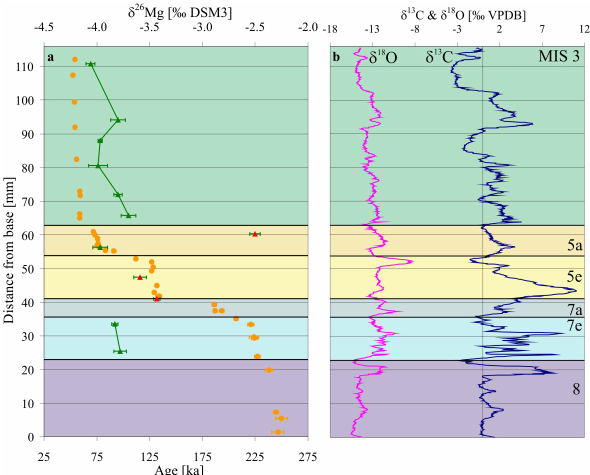
Fig. 10. Magnesium, carbon and oxygen isotope data and age data of flowstone SPA 59 from Spannagel Cave, Austria. Thick black lines indicate hiatuses. (a) Mg-isotope data (green) and age data (orange) plotted against distance from base in mm (age data from Holzk¨amper et al., 2005). Red triangles indicate samples taken in detritus layers. (b) Carbon (dark blue) and oxygen (magenta) iso- tope data plotted against distance from base in mm (data from Holzk ¨ amper et al., 2005). Marine isotope stages after Sp ¨ otl et al.